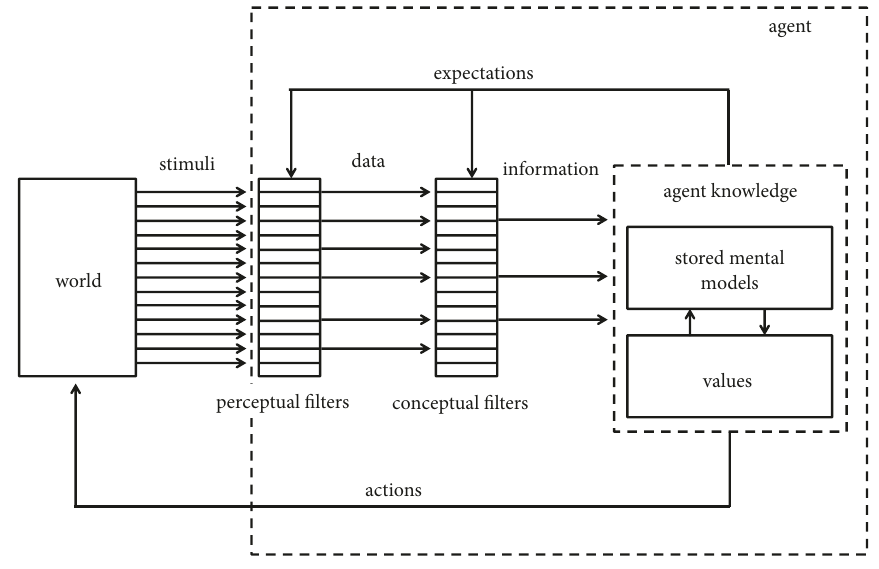
Figure 1: The agent-in-the-world model